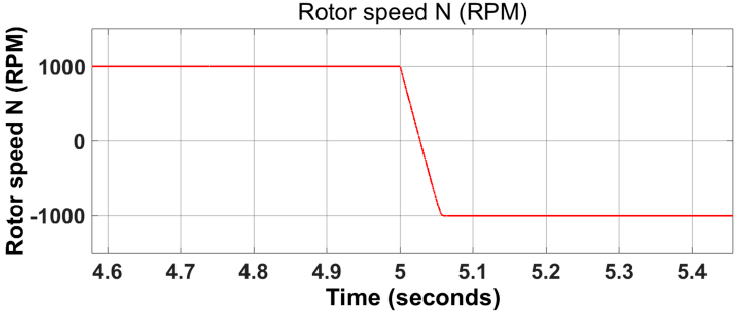
Figure 11. Expanded view of first two passes for forward-reverse rolling.